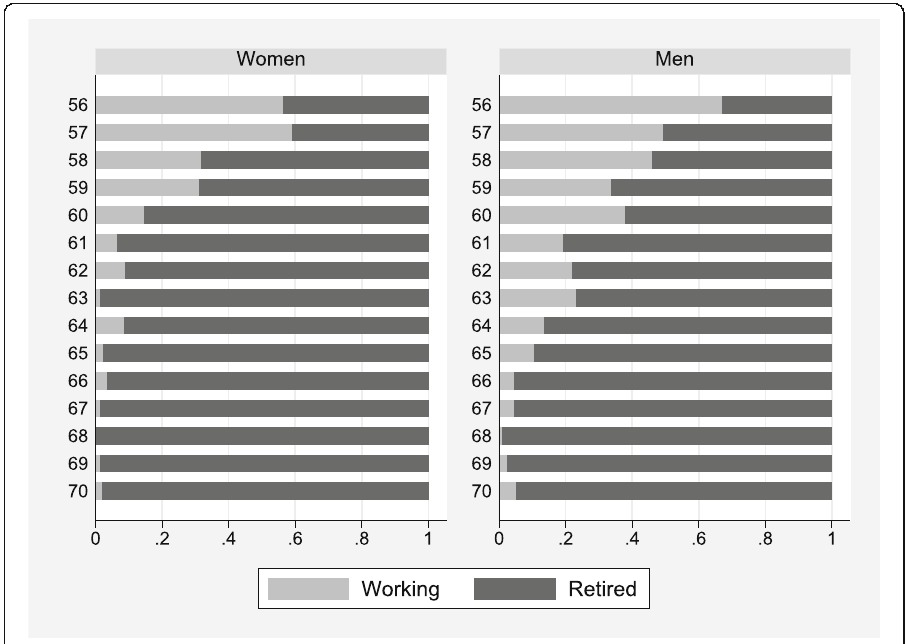
Fig. 1 Distribution of working and retired respondents, by age. Notes: 2670 observations (962 women and 1708